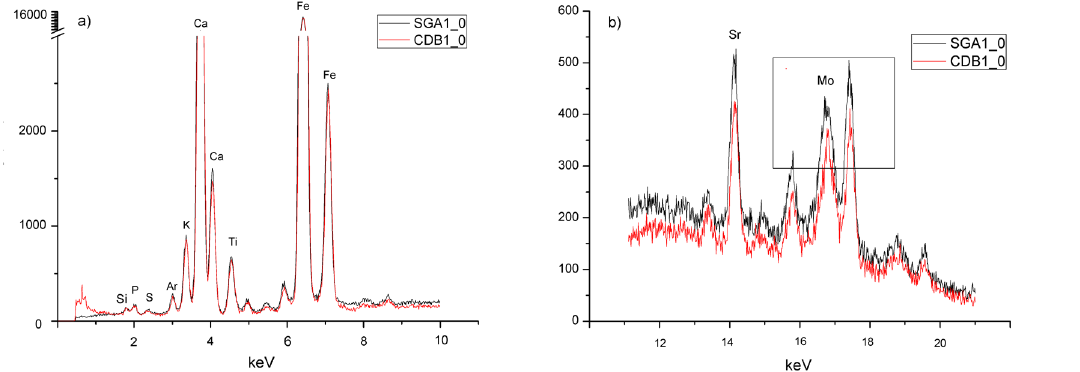
Figure 4. Comparison between the X-ray Fluorescence spectra of selected clays, not purified nor sieved: SGA1_0 and CDB1_0, in the energy regions 1-10 keV (a) and 10-20 keV (b). The three peaks in the high energy region come, in order of decreasing energy, from Rayleigh diffusion, Compton scattering and escape peak of anode Mo. peak intensities of the two clays (SGA and CDB) before (label 1) and after purification (label 4). Table 3. K α